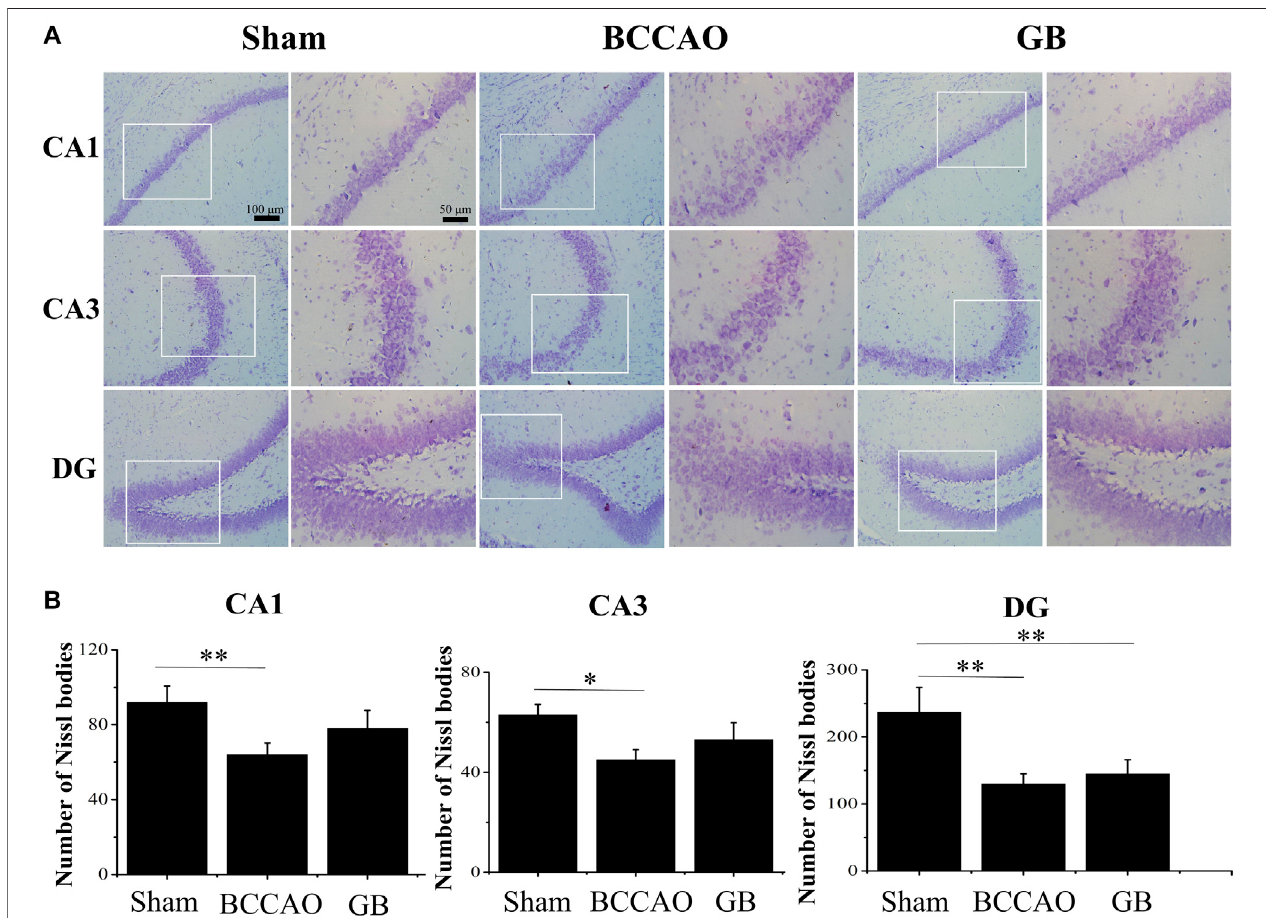
FIGURE 6 | NisslstainingofCA1,CA3,DGregionofrathippocampusofshamgroup,BCCAOgroupandGBtreatedBCCAOgroup.TheNisslbodywasstainedpurple-blue. (A) Representative Nissl staining images in hippocampus of sham group, BCCAO group and GB treated BCCAO group. (B) Quantitative analysis of the number of Nissl bodies in hippocampus of sham group, BCCAO group and GB treated BCCAO group. Data are expressed as means ± SD (n (cid:1) 3), * p < 0.05, ** p < 0.01. Scale bar: 100 and 50 μ m.